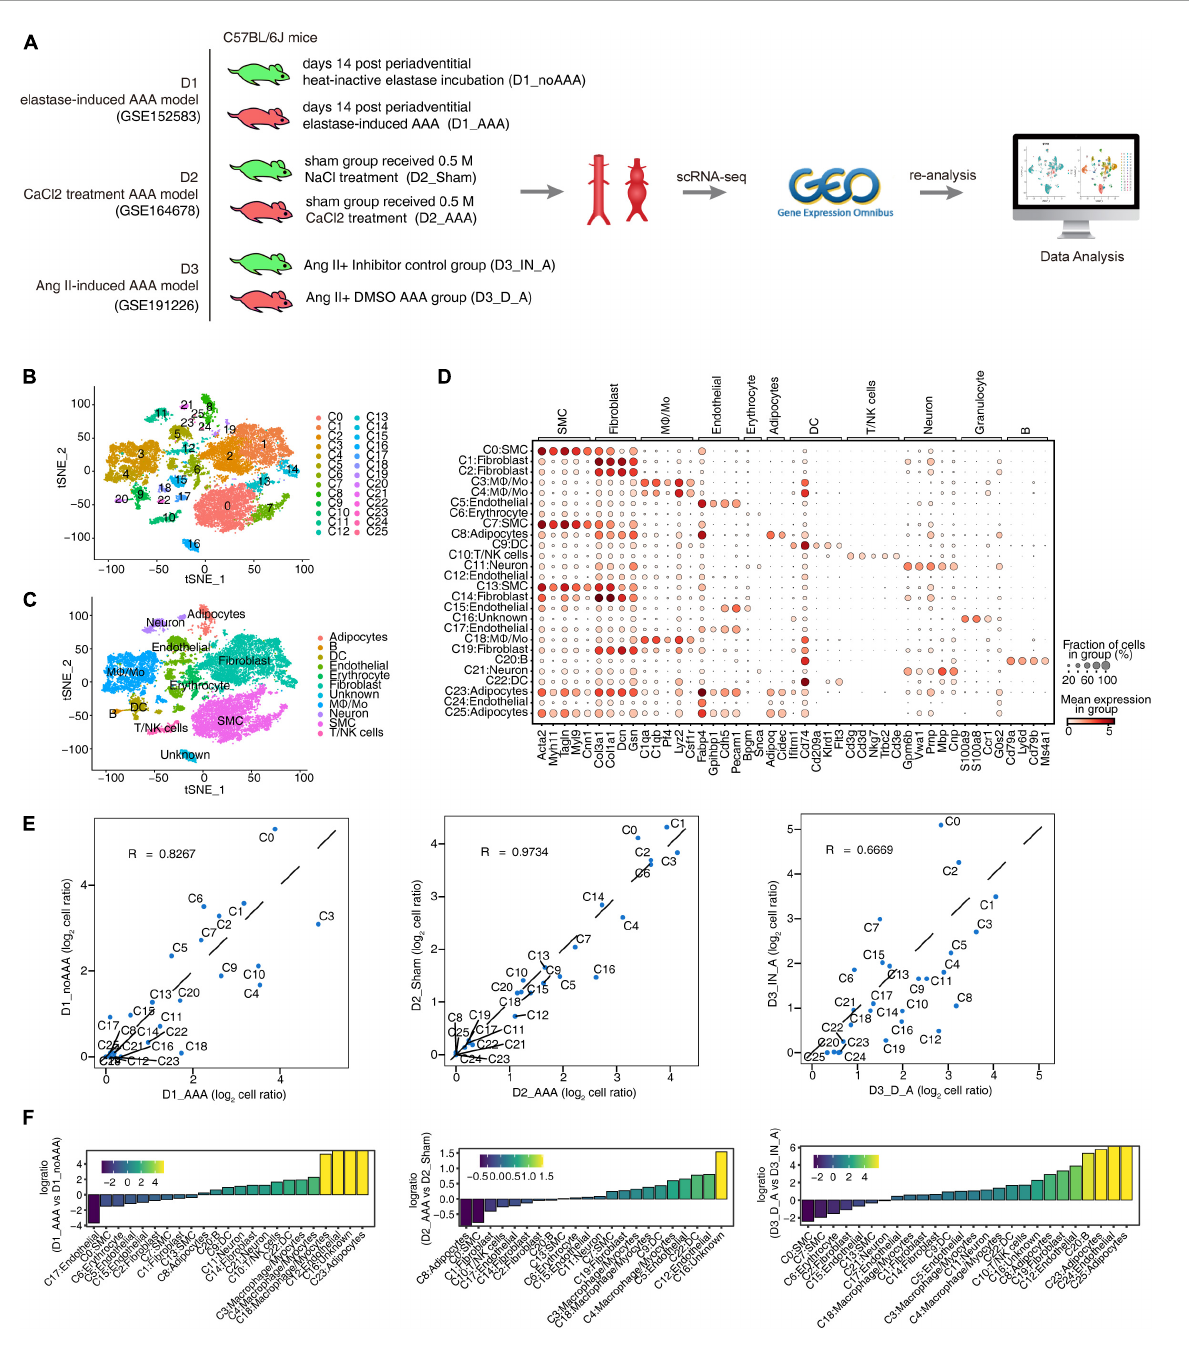
FIGURE1 Single-cell RNA sequencing (ScRNA-seq) analysis of abdominal aortic tissue from different mouse abdominal aortic aneurysm (AAA) models identified distinct macrophages/monocytes (M ϕ /Mo) types. (A) Schematic illustration of sample preparation and scRNA-seq data processing. (B, C) t-distributed stochastic neighbor embedding (tSNE) plot of composite single-cell transcriptomic profiles from all six abdominal aortic samples from three datasets. Colors indicated cell clusters along with annotations. M ϕ /Mo, macrophage/monocyte cells; SMC, smooth muscle cells; DC, dendritic cells. (D) Dot plot showing expression of representative genes in each cell type. (E) Scatter plot comparing the proportions of cell populations of each cell type in two groups. (F) Rank order based on decreasing values of the relative frequency ratio between two sample